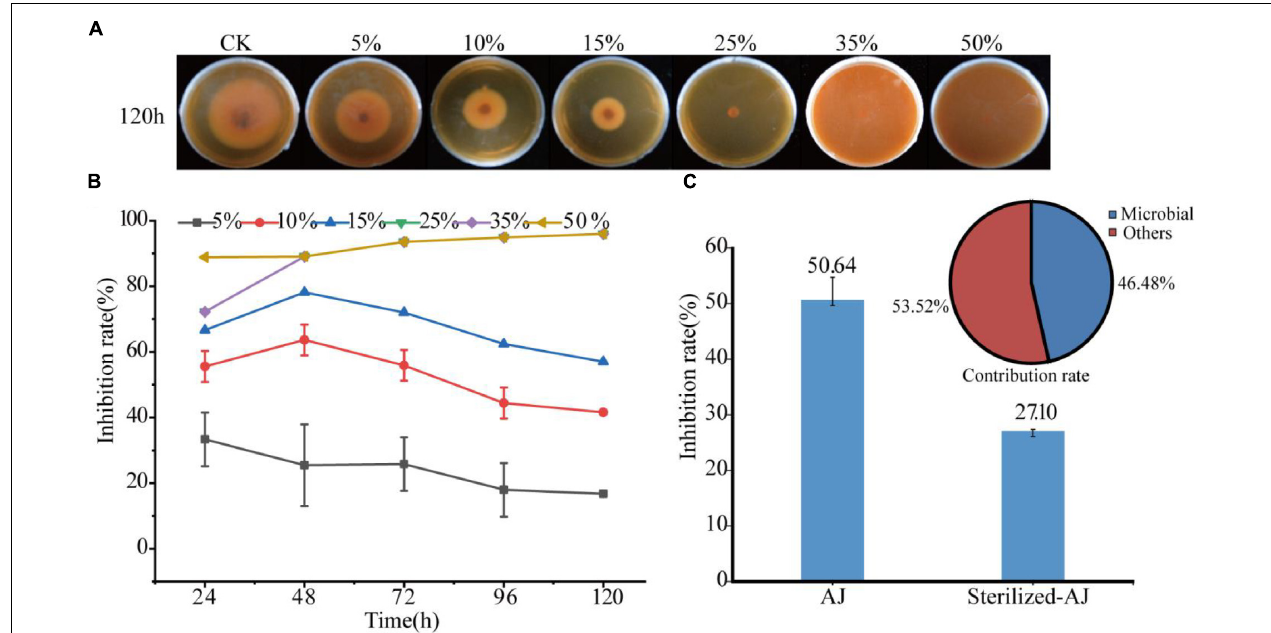
FIGURE 2 | Antifungal activity: (A) antifungal test photos taken at 120 h; (B) inhibition rate of different dosages of AJ at different times; (C) inhibition rate and contribution rate of different AJ components. AJ, 10% AJ; sterilized-AJ, 10% sterilized AJ. Data are mean ± standard deviation, n =